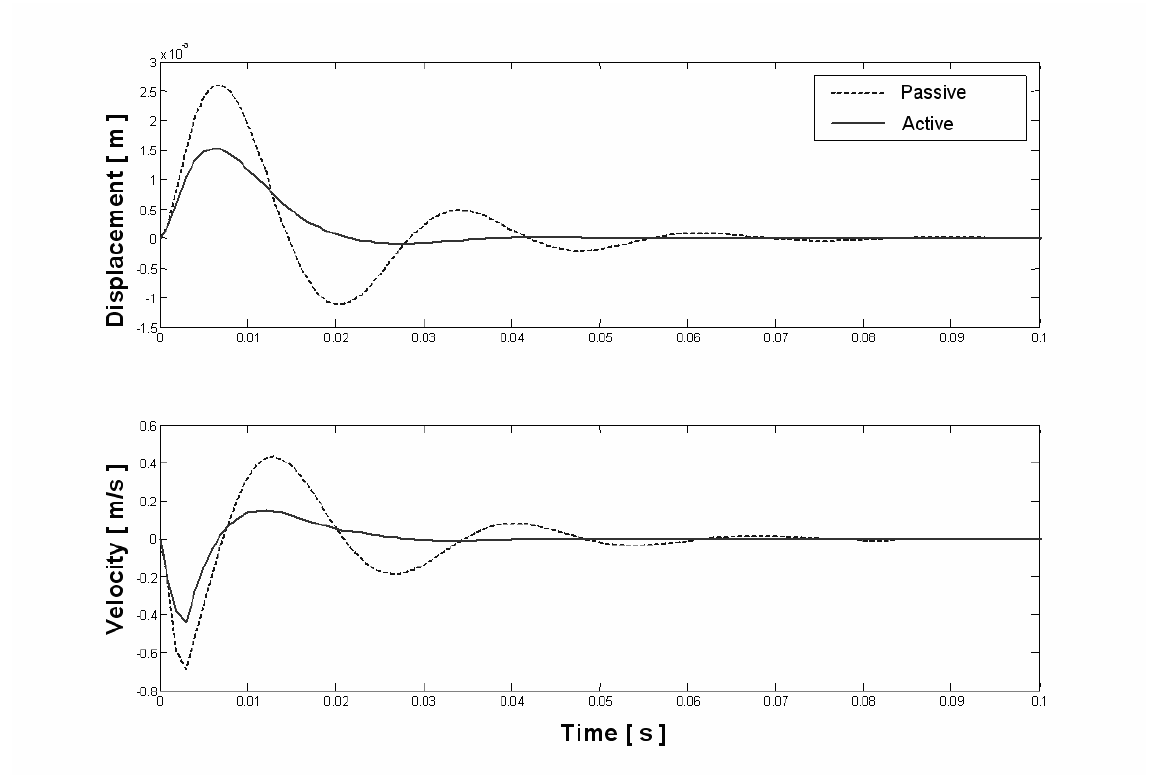
Fig. 13. Impulsive force response of the active and passive system.